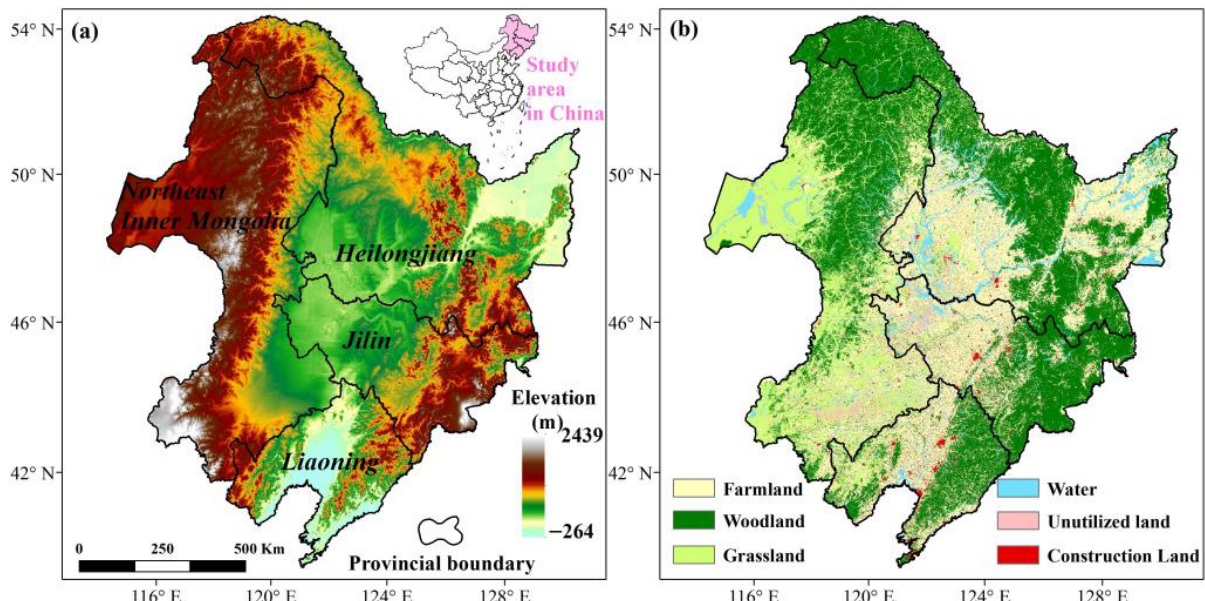
Figure 1. Location ( a ) and land use type ( b ) of the study area.